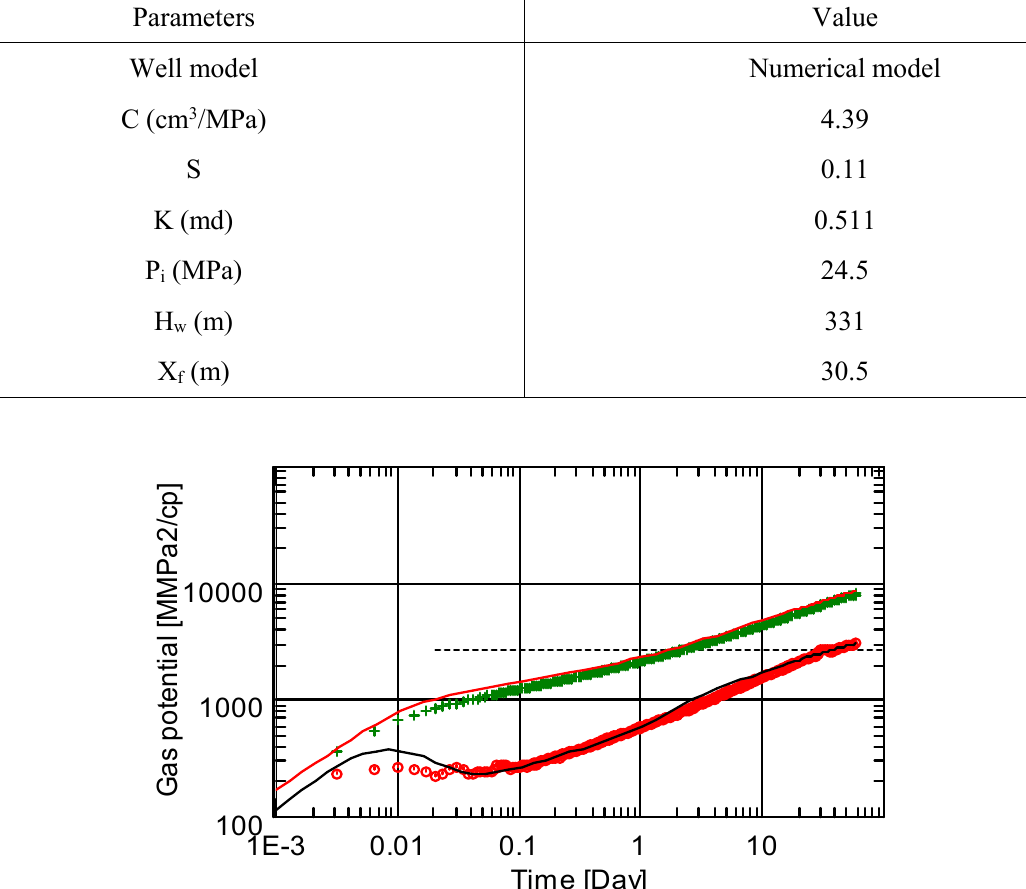
Figure 10—Log-log curves of numerical well test of SuA-B-CH2 well.